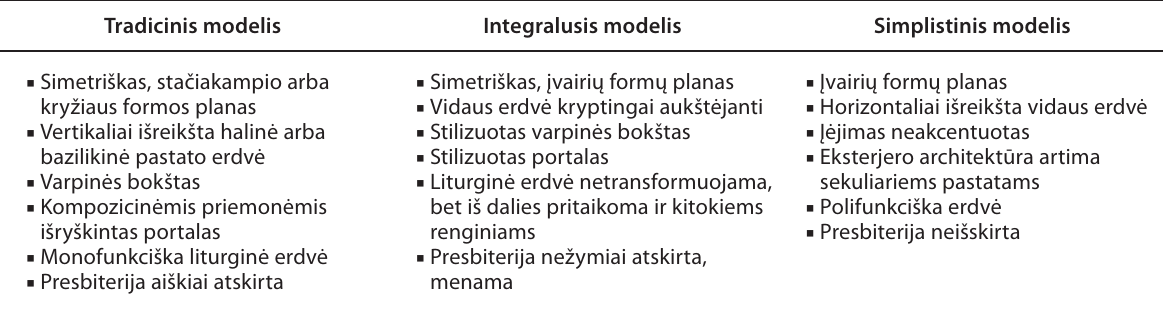
Table 2. Typology of architectural expression in church